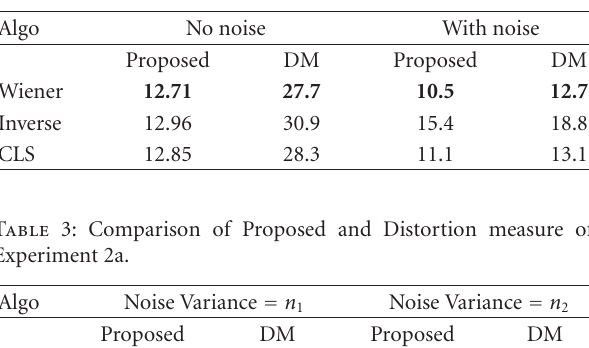
Figure 4: Results of Exp 2c. (a) Proposed versus lambda, (b) DM versus lambda. Table 2: Comparison of Proposed and Distortion measure of Experiments 1a and 1b.